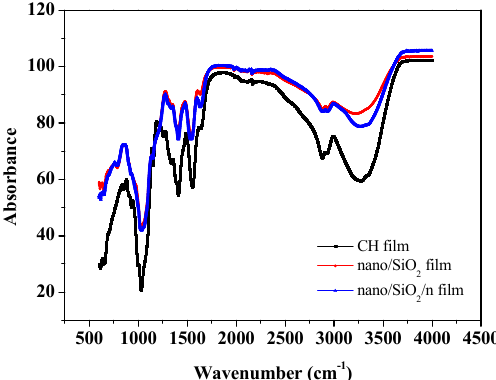
Figure 2. FTIR spectra deposited for different novel films.